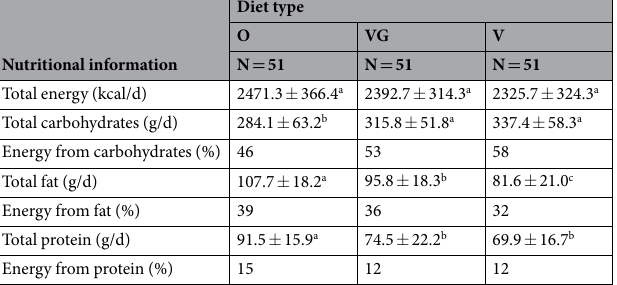
choices ( P < 0.001 for both PCs), as well as within each diet group (% of variability at Supplemental Table S3) (Fig. 2b). The O group, with high scores for PC1 and low scores for PC2, was defined as a dietary choice with higher CF, WF, and EF values, higher consumption of proteins and fats while lower consumption of carbohydrates,